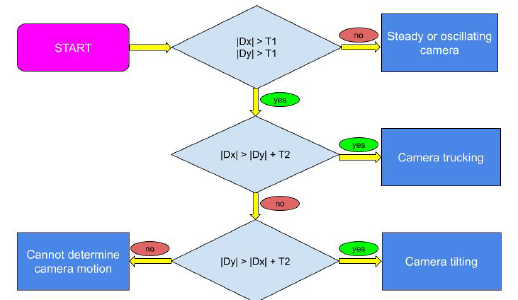
Figure 3. Workflow of the camera motion estimation